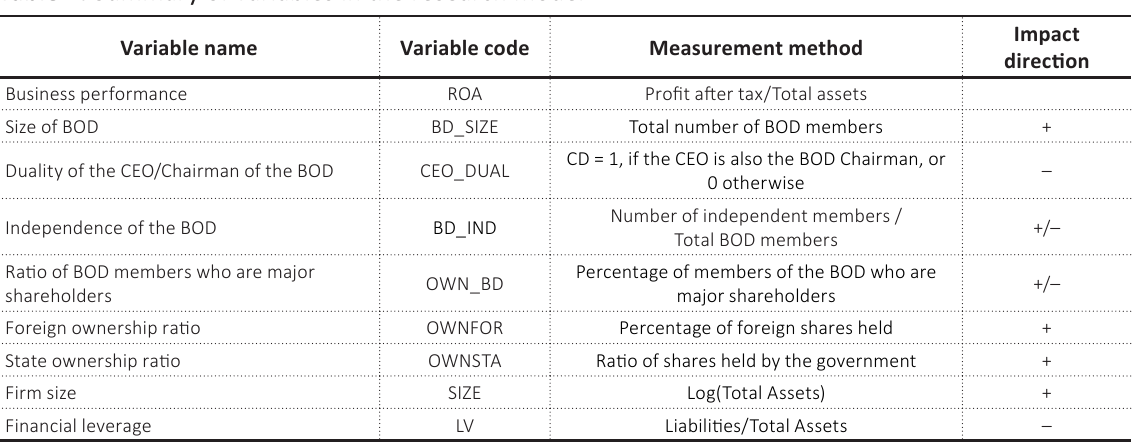
Table 1. Summary of variables in the research model